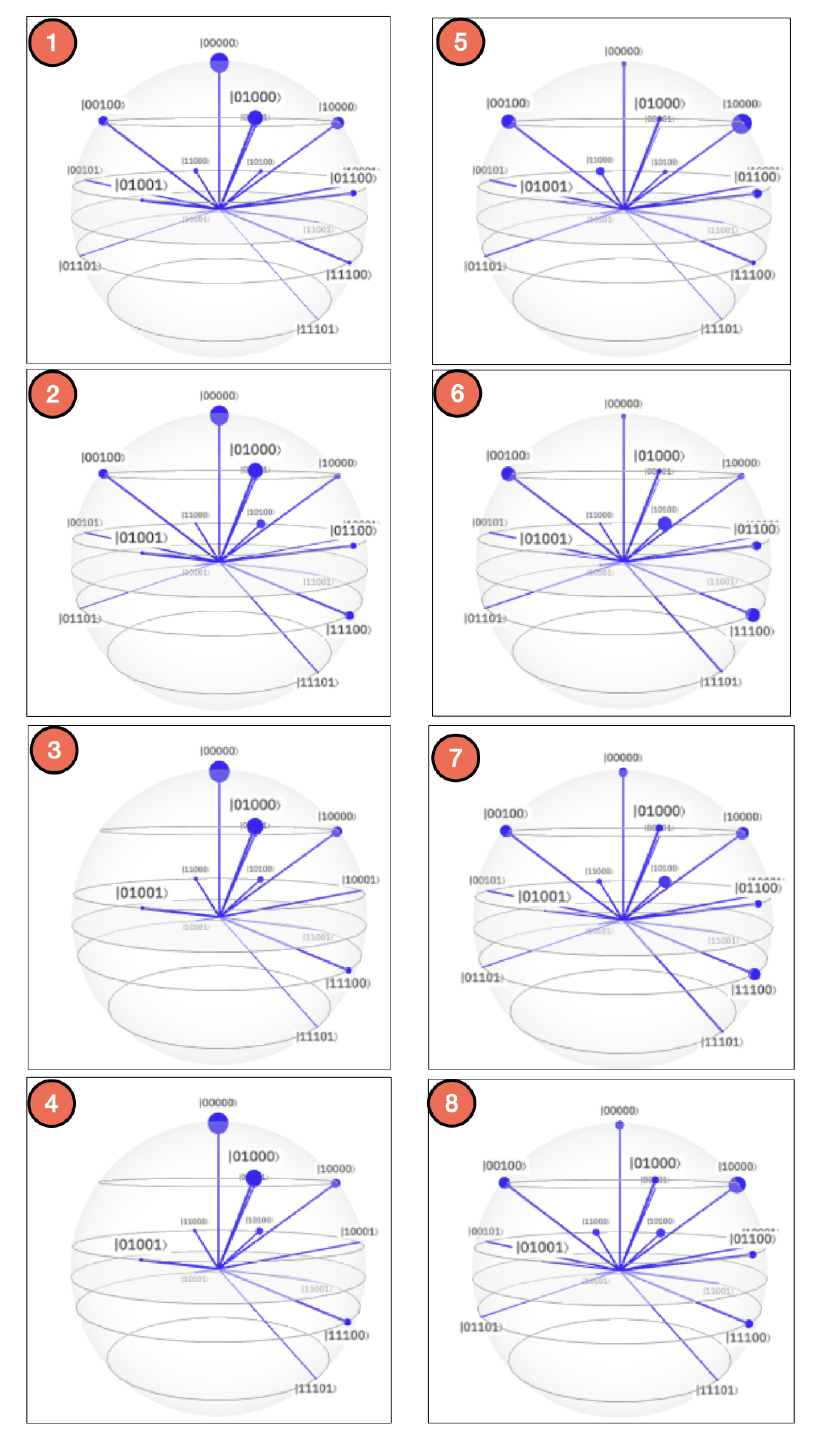
Figure A1. QSOD Bloch sphere measurements steps